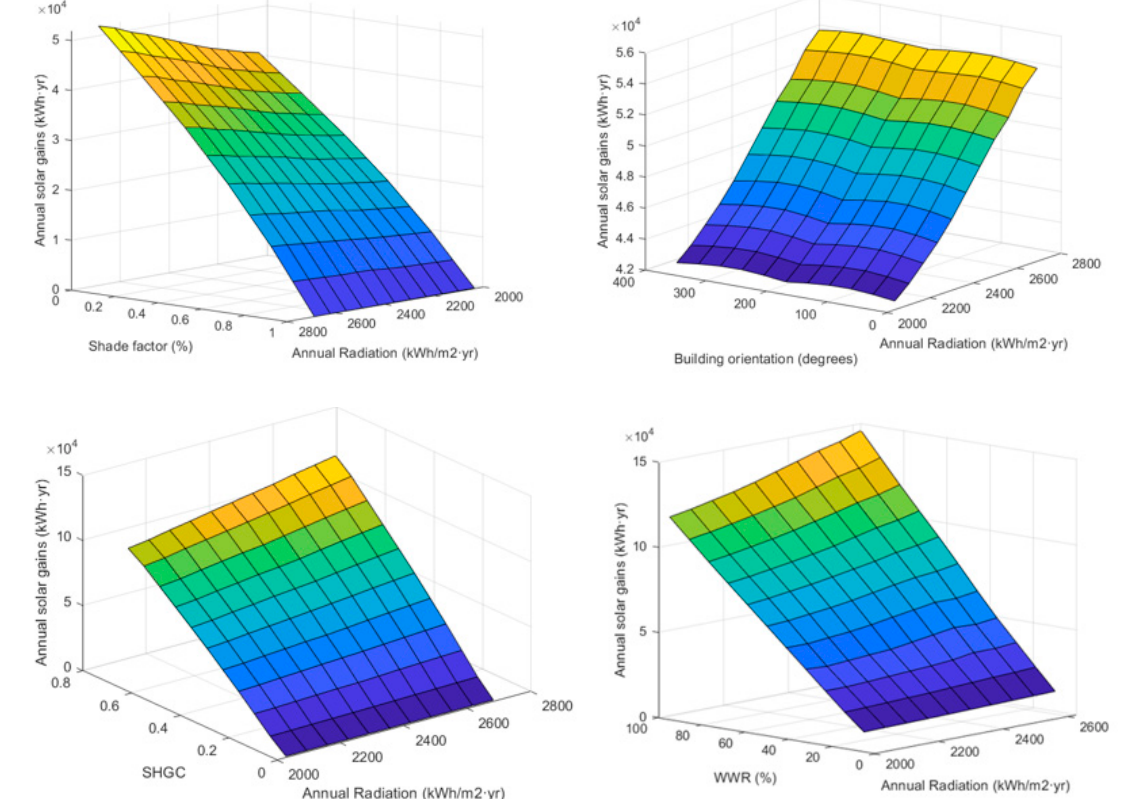
Figure 7. Shade factor/annual solar heat gains, first building (up, left); SHGC/annual solar heat gains correlation, third building (up, right); Orientation/solar heat gains, first building (down, left); WWR/solar heat gains, first building (down, right).